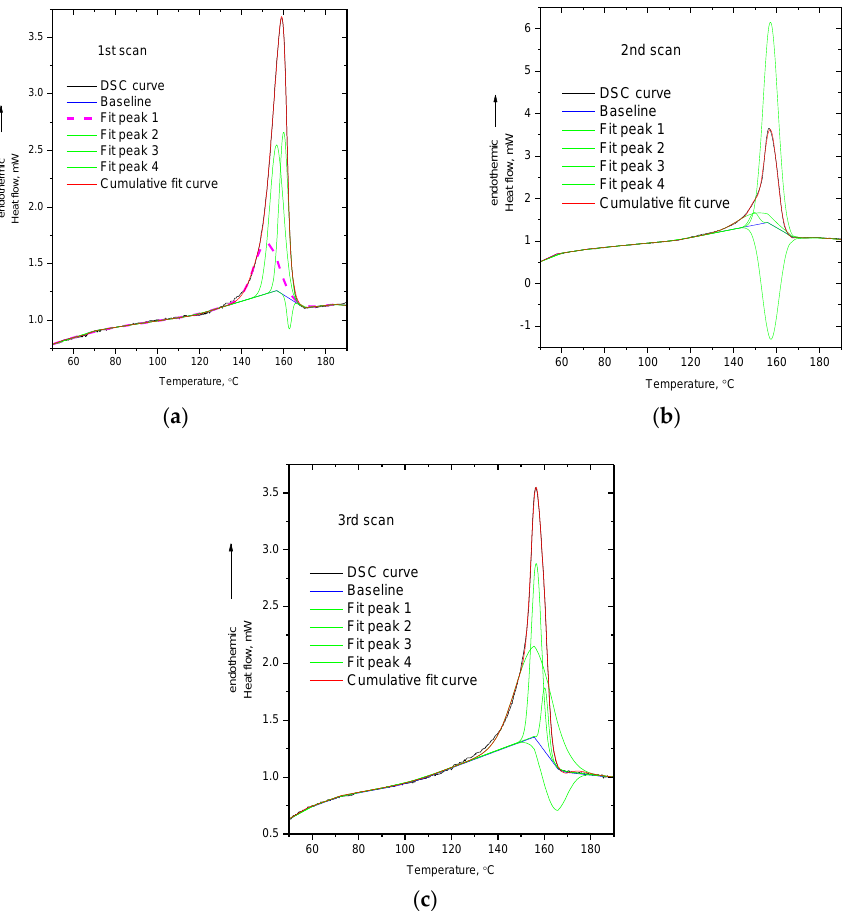
Figure 5. Fitting of the DSC curves of PP-g-MA: ( a ) first scan; ( b ) second scan; ( c ) third scan. The area of the first fit peak (shown with pink dashed line in Figure 5a) at 151 ◦ C of the DSC peak of the first scan represents the 26% of the area of the cumulative peak. The cumulative peak corresponds to the value of 167.4 mJ as measured by DSC, thus the first fit × 167.4 = 44.2 mJ. In the DSC experiment, the mass sample was peak corresponds to 26 100 2.3 mg. From the TGA the % mass loss is known (0.37 ± 0.1 wt.%) [14]. By assuming that = 0.00851 mg. By